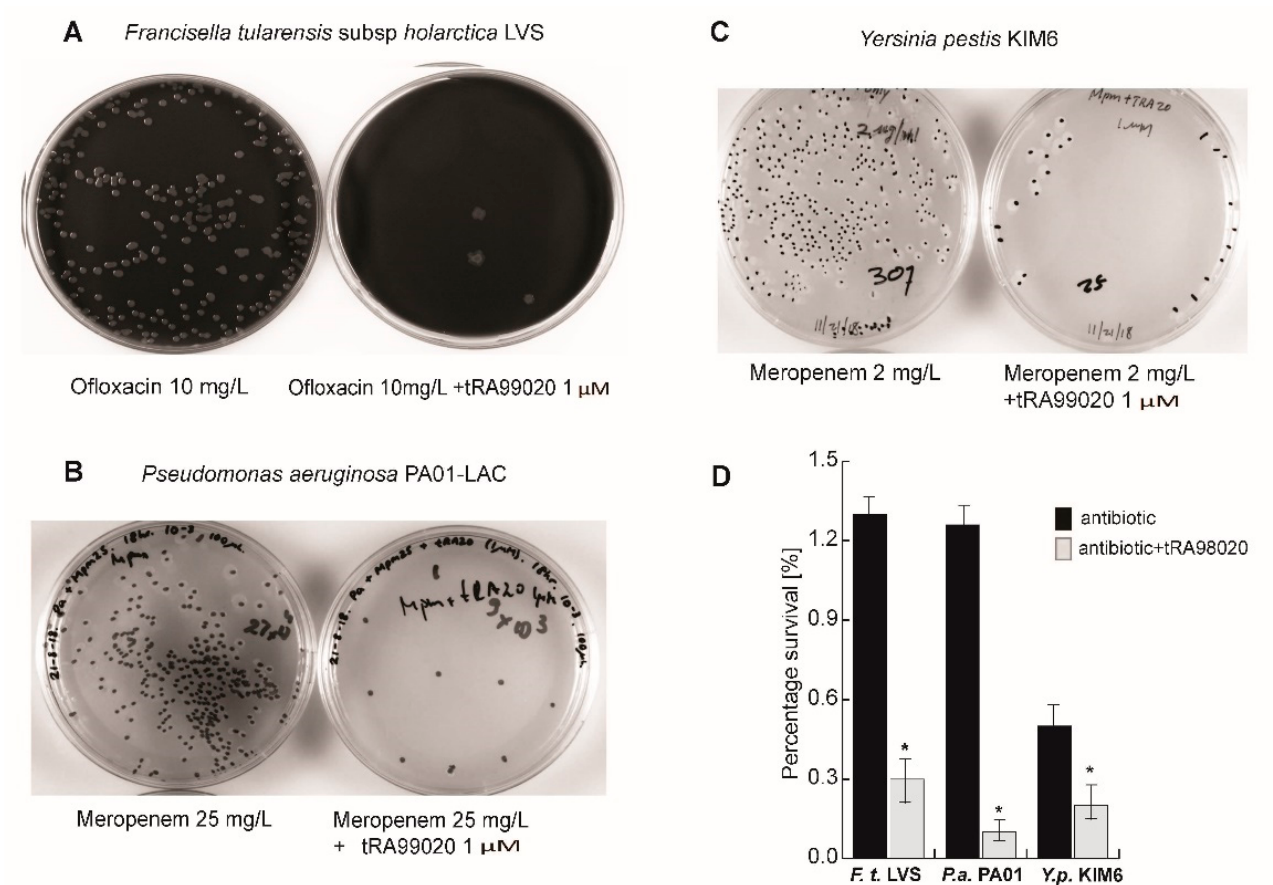
Figure 2. tRA99020 acts as broad-spectrum modulator of bacterial persistence. Bacterial cultures grown to early exponential phase (OD 0.2) were split to equal volumes and antibiotic alone or in combination with tRA9920 compound (1 µ M) were added. Upon incubation at 37 ◦ C on antibiotic-free agar plates, the percentage of bacterial survival was determined via limiting dilutions of bacterial cultures relative to the bacterial counts prior to drug treatment. ( A ) Shown are F. tularensis LVS colony forming units on chocolate blood agar plates at equal log 10 (2) dilution rates after 72 h of bacterial growth recovery; ( B ) recovery of P. aeruginosa PA01-LAC persisters post-antibiotic treatment was evaluated on LB (Miller) agar plates at 24 h of incubation; ( C ) the effect of tRA99020 on Y. pestis KIM6 persistence was evaluated on brain heart infusion agar at 48 h of incubation; ( D ) the average and standard deviations of bacterial survival rates from four independent experiments are shown. For each experiment, the CFU/mL was determined from three technical replicates of colony counts from agar plates with dilution rates resulting in clear separation of individual colonies (10–100 CFU). The significance (*, p < 0.01) of tRA99020 effect was calculated with a Student’s t test.